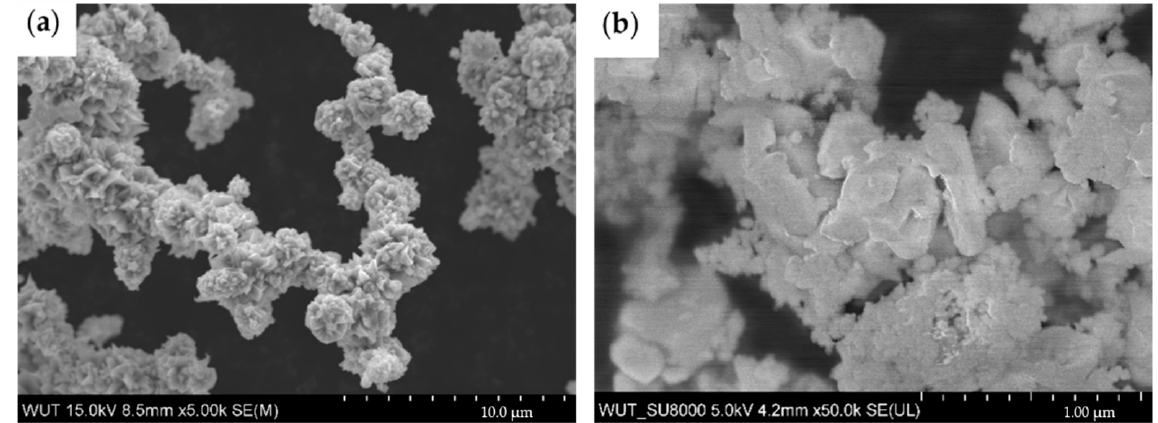
Figure 4. SEM images of ( a ) Ni powder, ( b ) SDC powder.